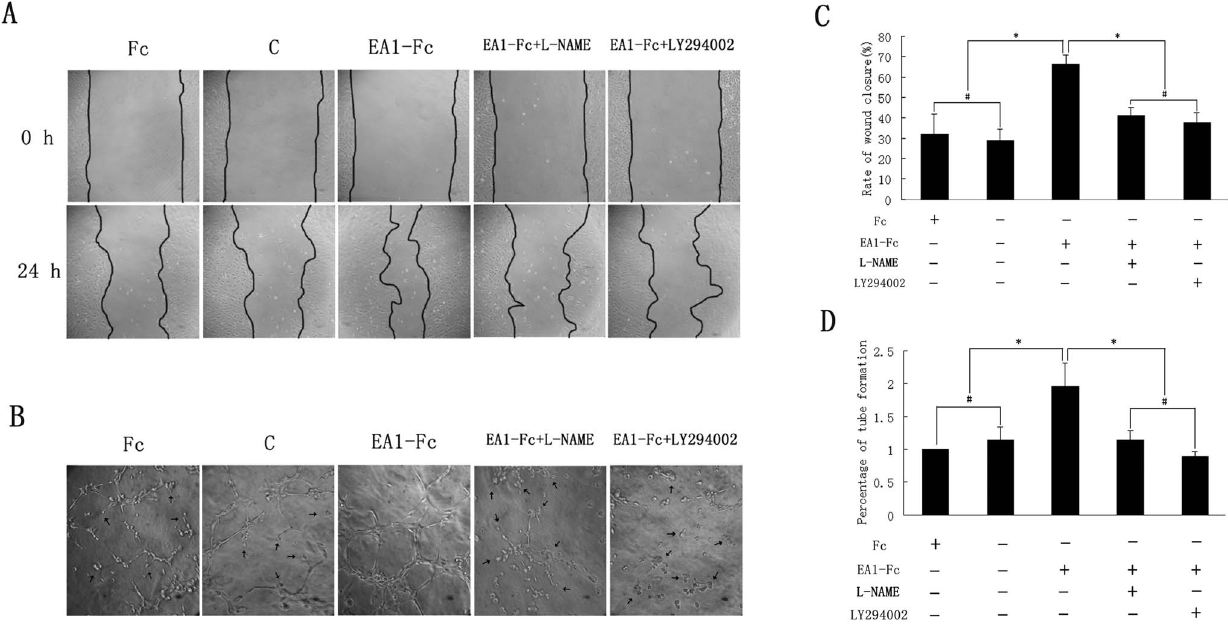
Figure 2. A critical role of eNOS/NO and PI3K/Akt in ephrin-A1-Fc activation of angiogenesis in HUVECs. A: Cell migration assay showed that L-NAME and LY294002 inhibited ephrin-A1-stimulated migration of HUVECs (200 6 ). B: Tube formation assay showed that L-NAME and LY294002 inhibited ephrin-A1-stimulated tube formation of HUVECs (200 6 ). Arrowheads presented the HUVECs that stretched insufficiently. C: Quantification of A. D: Quantification of B. (*, P , 0.05, n=3).